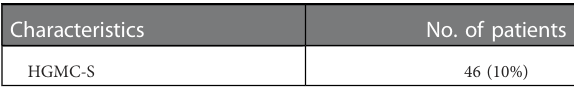
TABLE 1 Patients ’ clinical and demographic